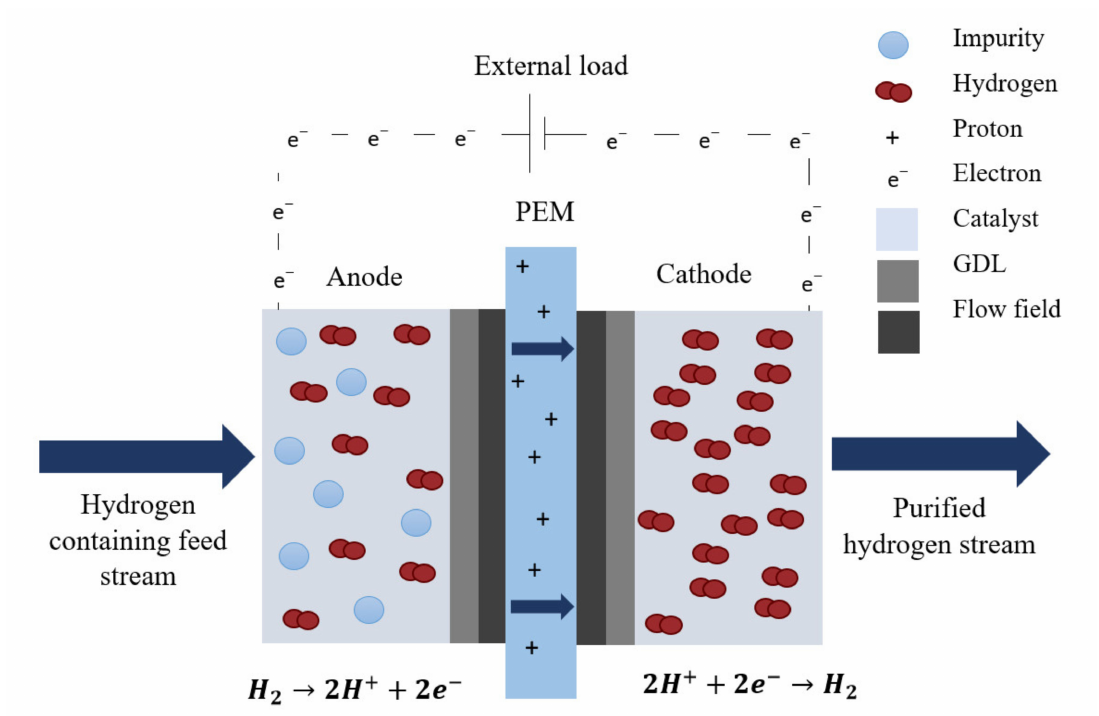
Figure 1. Working principal of an ideal electrochemical hydrogen separator